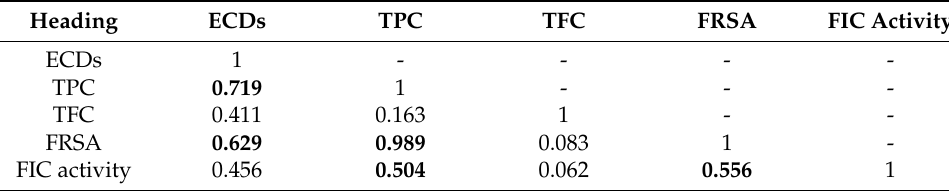
Table 6. Correlation matrix of the studied parameters (Pearson correlations coefficients) 1